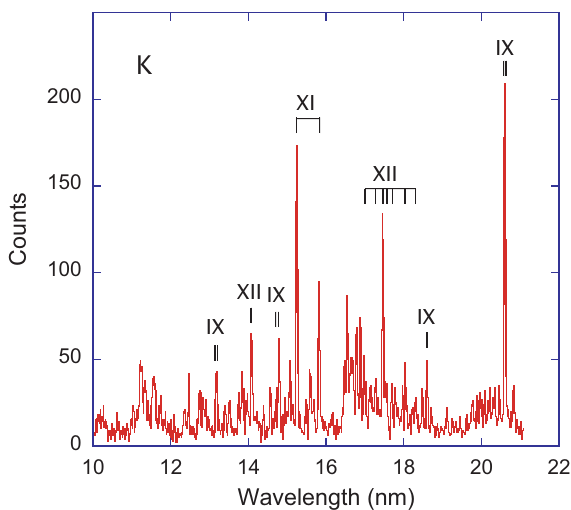
Figure 8. Spectrum of K at an ion beam energy of 12.8MeV. Line width 0.035nm. The most prominent lines are marked by the spectrum number. The detection efficiency rises from the left to the right of the figure by a factor of about four